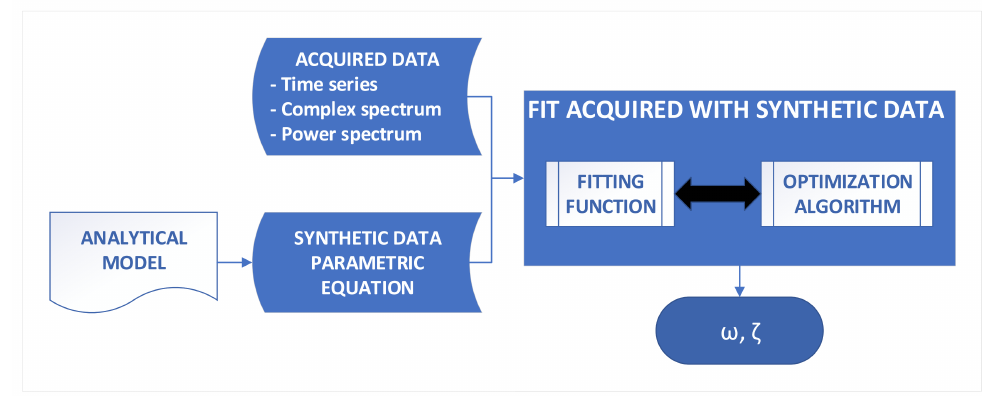
Figure 8. Data processing paradigm